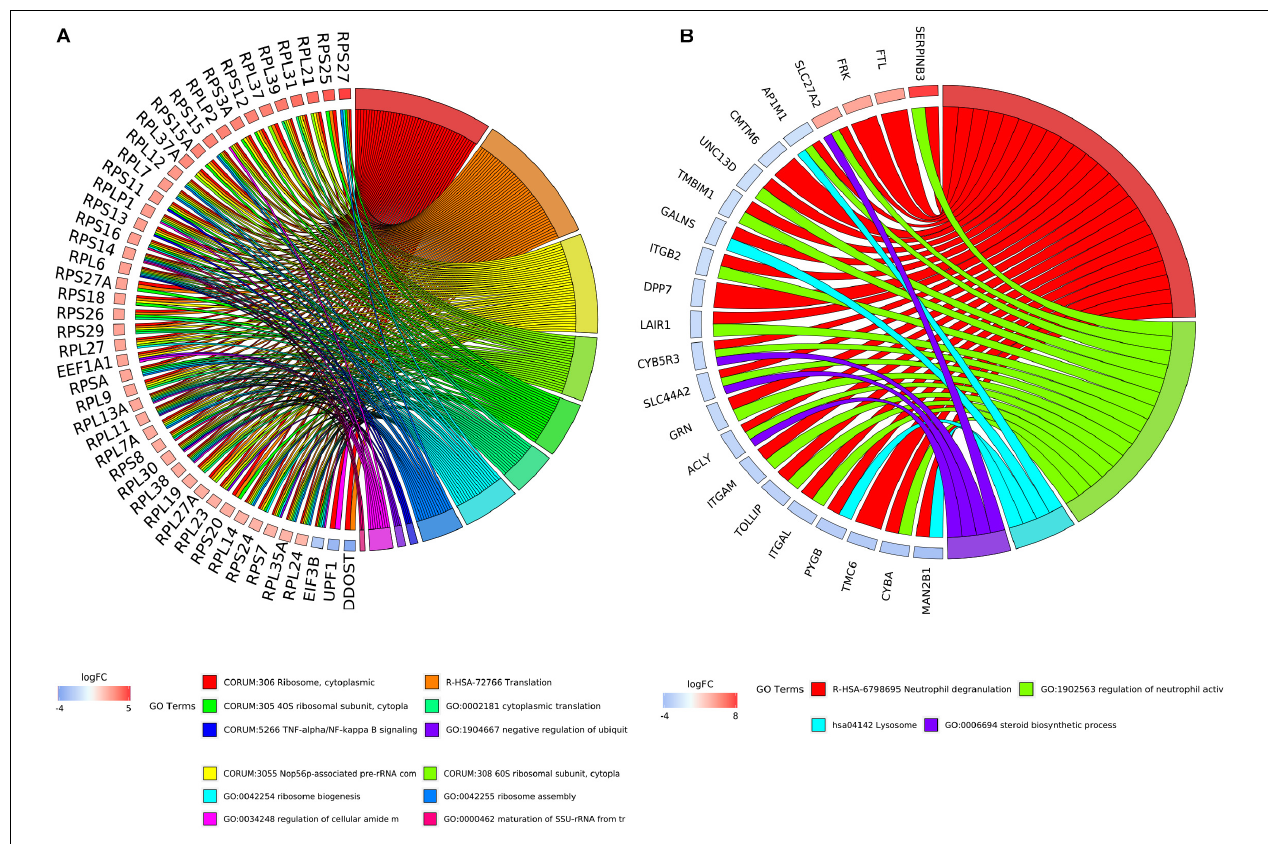
FIGURE 5 | The relationship between enriched biological process terms and DEGs in clusters. (A) Cluster 1. (B) Cluster 2. The colors of the nodes are illustrated from red to blue in descending order of logFC. The genes were ordered according to their logFC values.